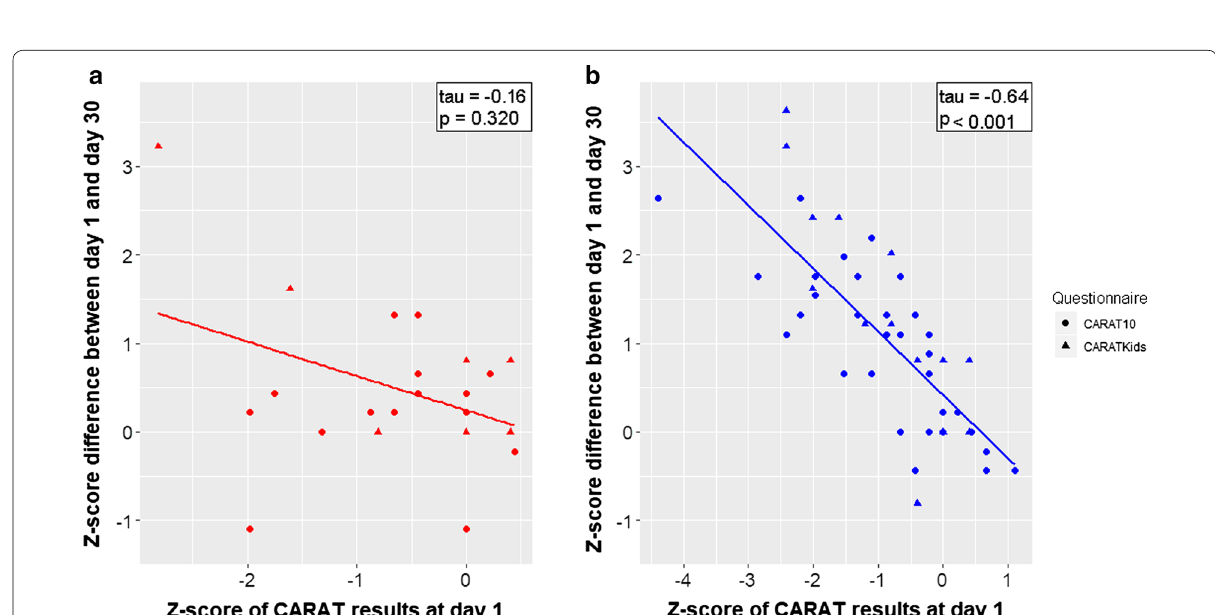
Fig. 4 Correlation of initial (day1) CARAT Z‑scores and 30‑days Z‑score difference in the control group ( a ) and in the active group receiving nasal irrigations ( b